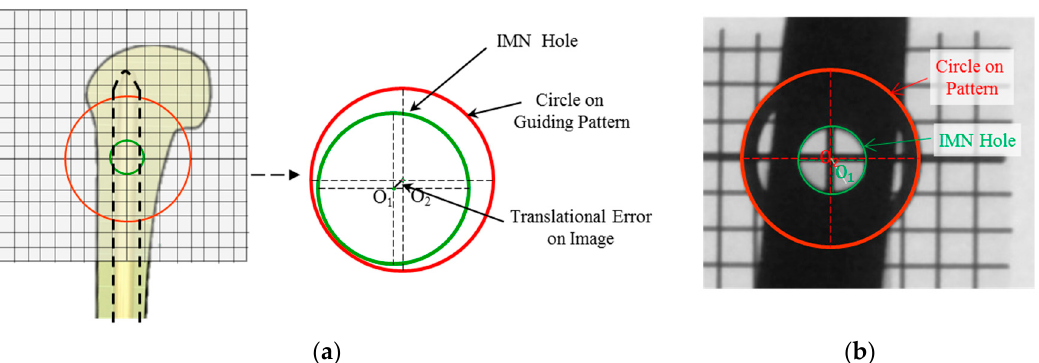
Figure 9. Definition of translational error. ( a ) Conceptual diagram. ( b ) Real X-ray image overlaid by colored circles.